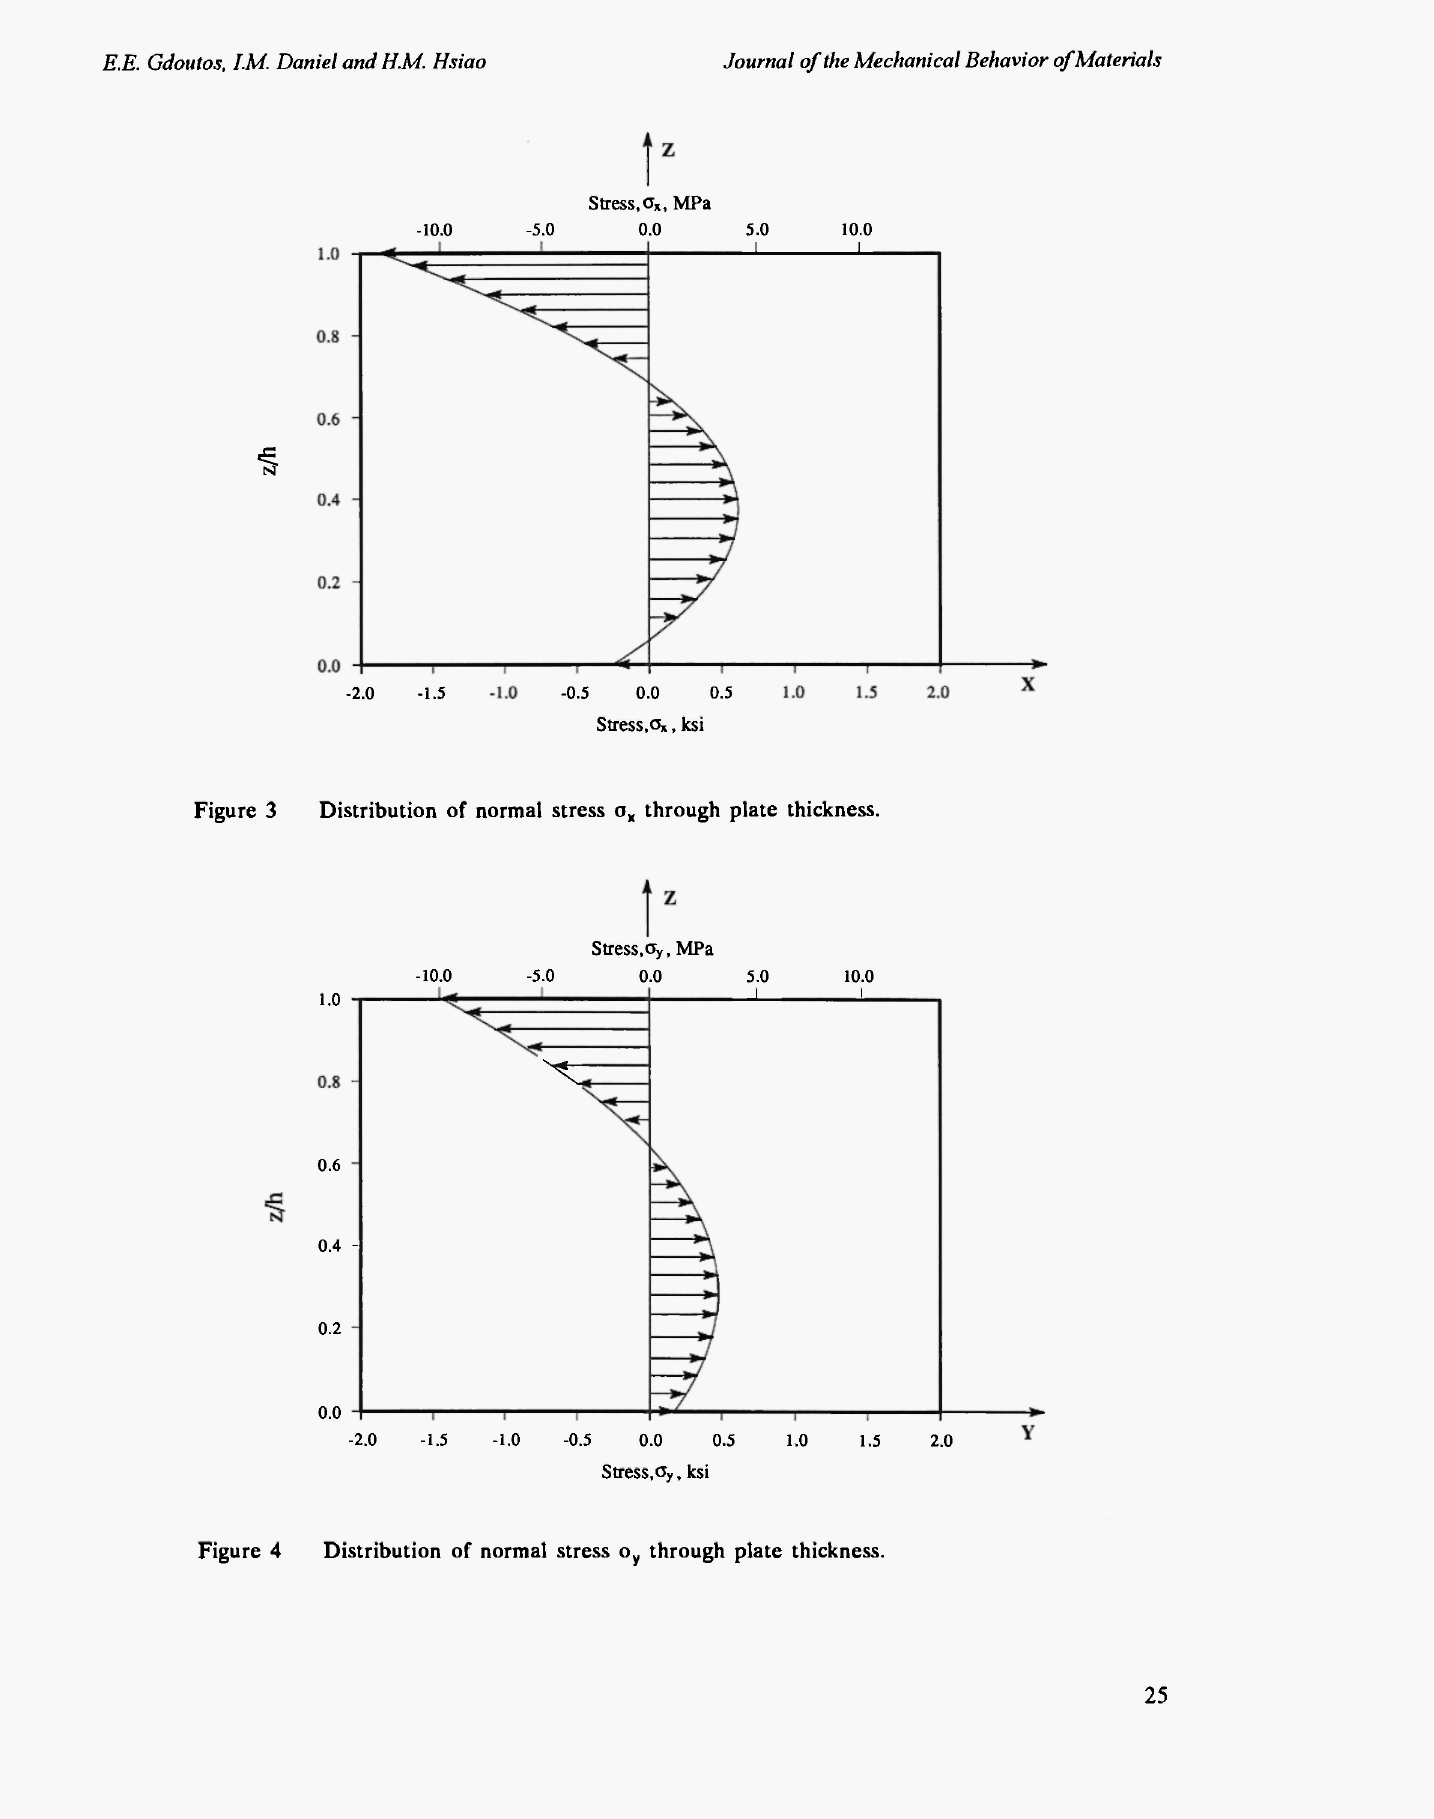
Figure 4 Distribution of normal stress o y through plate